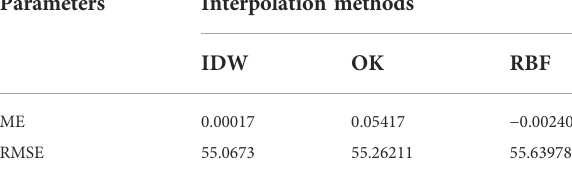
TABLE 6 Cross-validation parameters of different interpolation